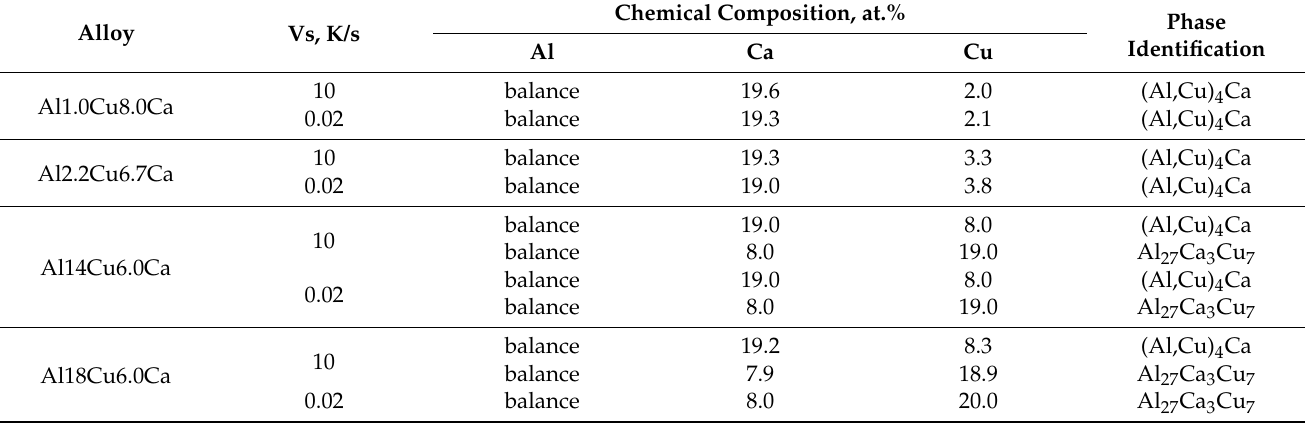
Table 2. Chemical composition of the phases detected in the alloys obtained at various cooling rates (Vs) upon solidification. Chemical Composition,